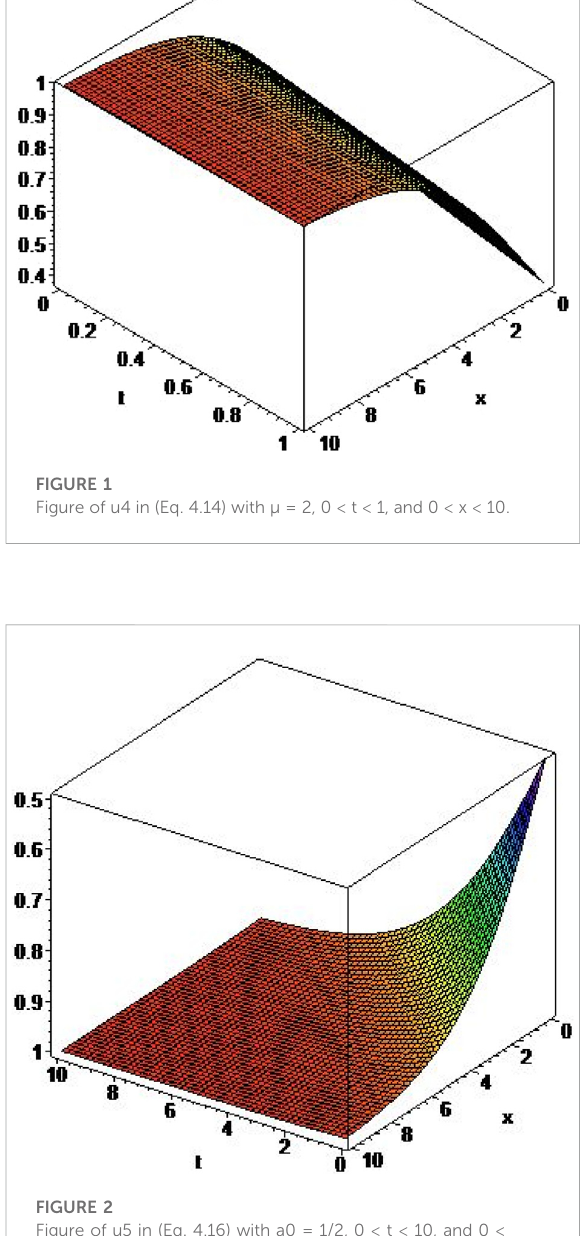
FIGURE 4 Figure of u9 in (Eq. 4.24) with μ = 2, 0 < t < 1, and 0 < x < 10.